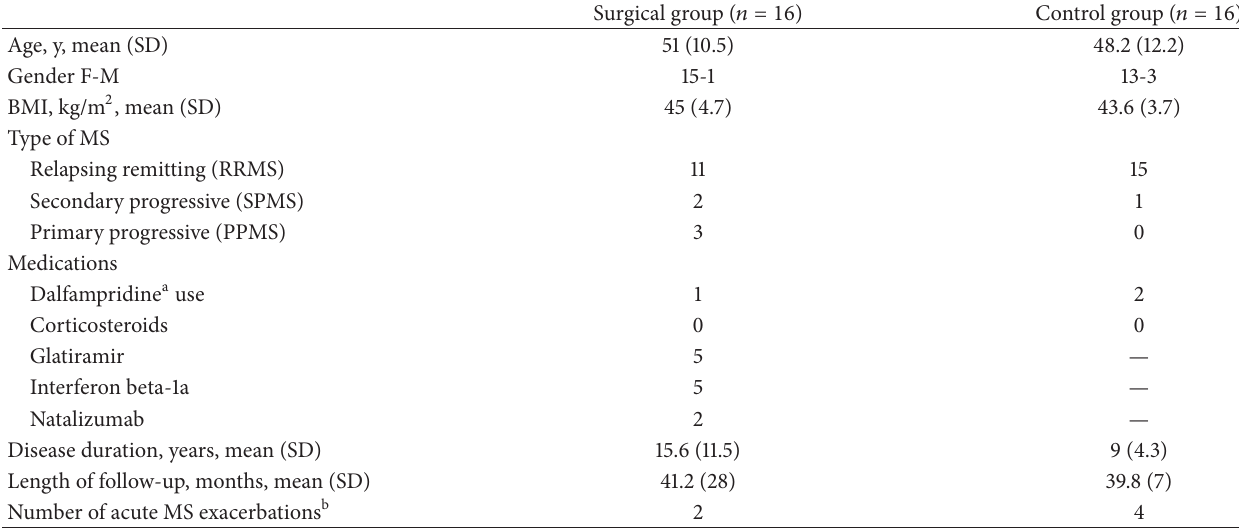
Table 1: Baseline characteristics of the surgical and control groups.